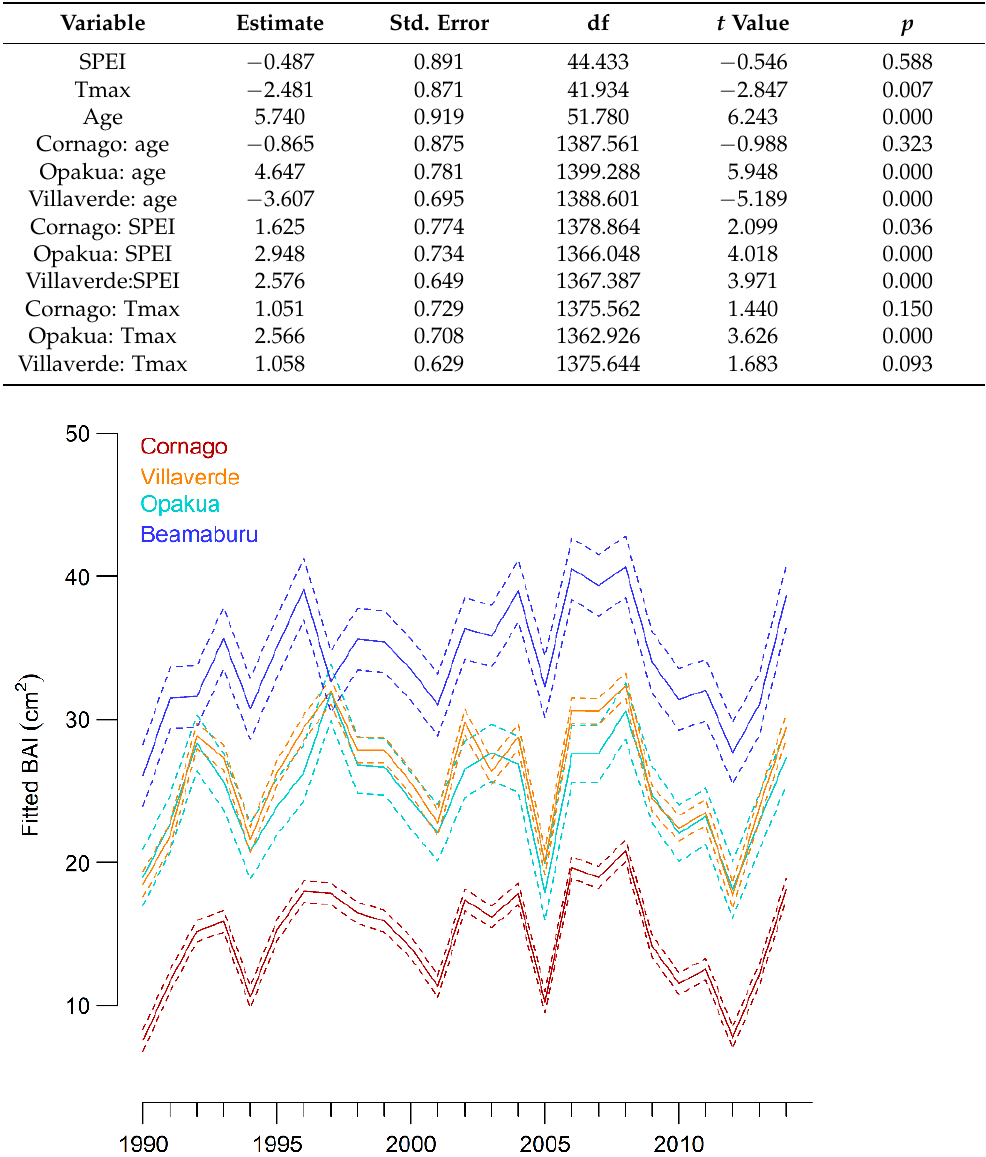
Figure 4. Expected growth (BAI, basal area increment) of Douglas fir trees for the period 1990–2014 if all sites are hypothetically forced to have the same age (i.e., standardized mean age values are 0). Continuous lines are means and dashed lines are 95% confidence intervals.